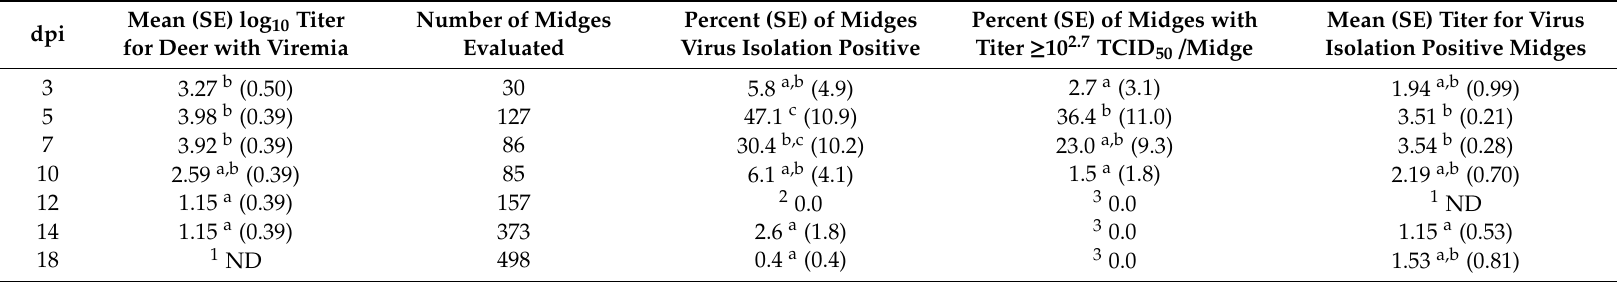
Table 1. Summary of virus isolation results by day post infection (dpi) for midges that fed from five deer experimentally infected with epizootic hemorrhagic disease virus (EHDV) serotype